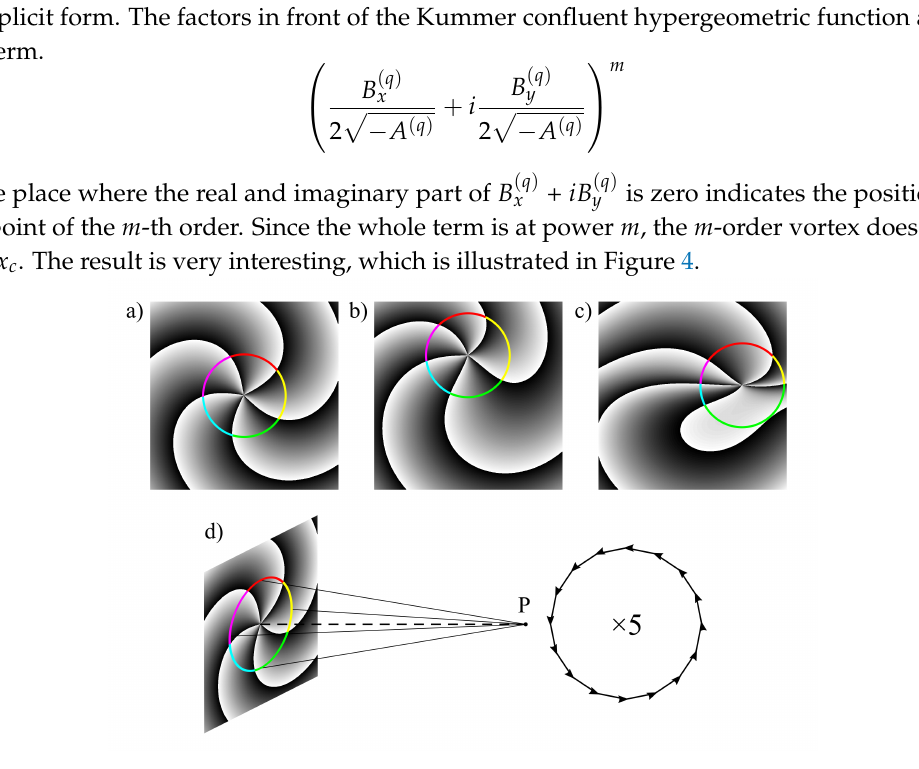
Figure 4. ( a ) The phase distribution of the optical vortex beam ( m = 5) for x c = 0 as seen just behind the SPP. Part ( d ) shows the sum of phasors calculated at point P (at image plane) on the optical axis, while going along the colored circle. Due to symmetry and 2 π phase change along the green part of the circle the phasors (from the green part) form a full circle at sum up to zero. Going along the parts marked with different colors will produce five such circles of phasors, at the same place, which again sum to zero; ( b ) when x c (cid:54) = 0, the symmetry breaks. In a typical case each part of the circle noted by different color will form zero at different point at the image plane, splitting the m -th order vortex into a set of single vortices. However, our case is untypical and the higher order vortex does not split; ( c ) when performing more complex operation as described below, we will produce even less symmetrical phase distribution, but the higher order vortex is still